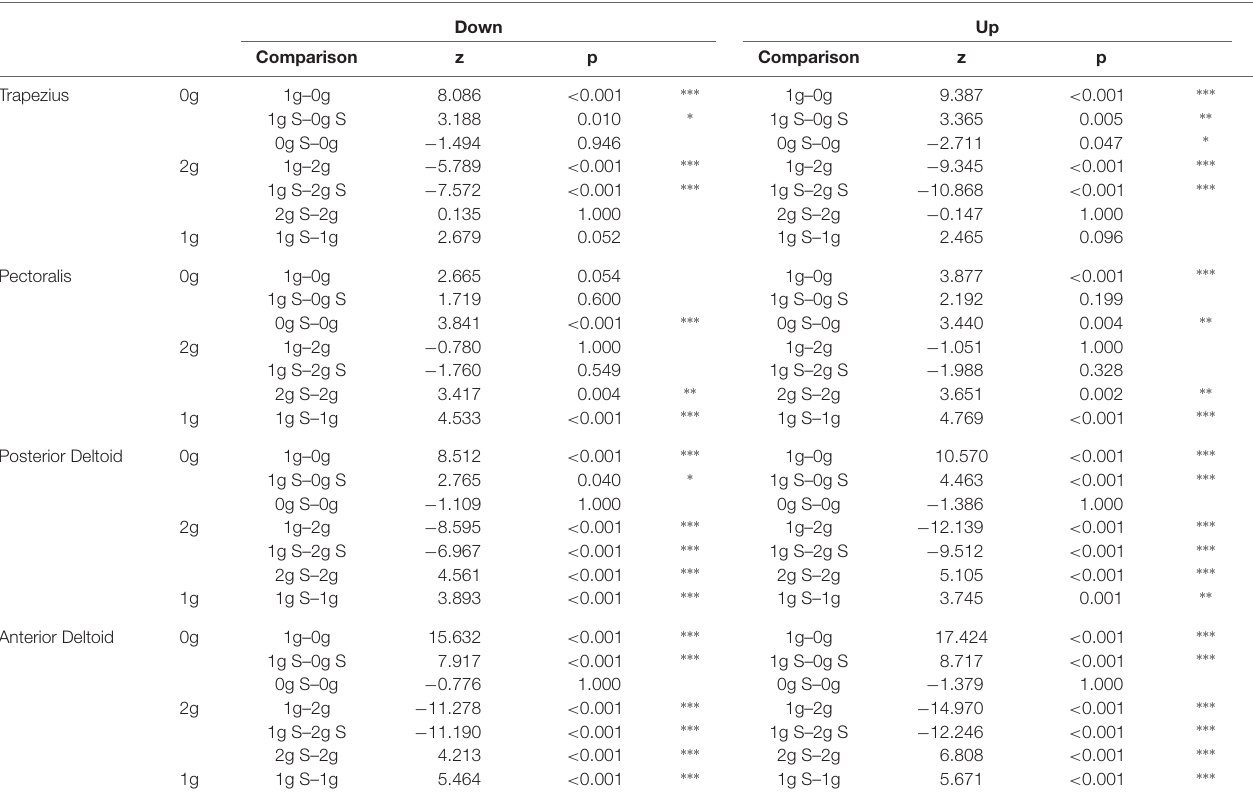
TABLE 6 | Post hoc analysis for